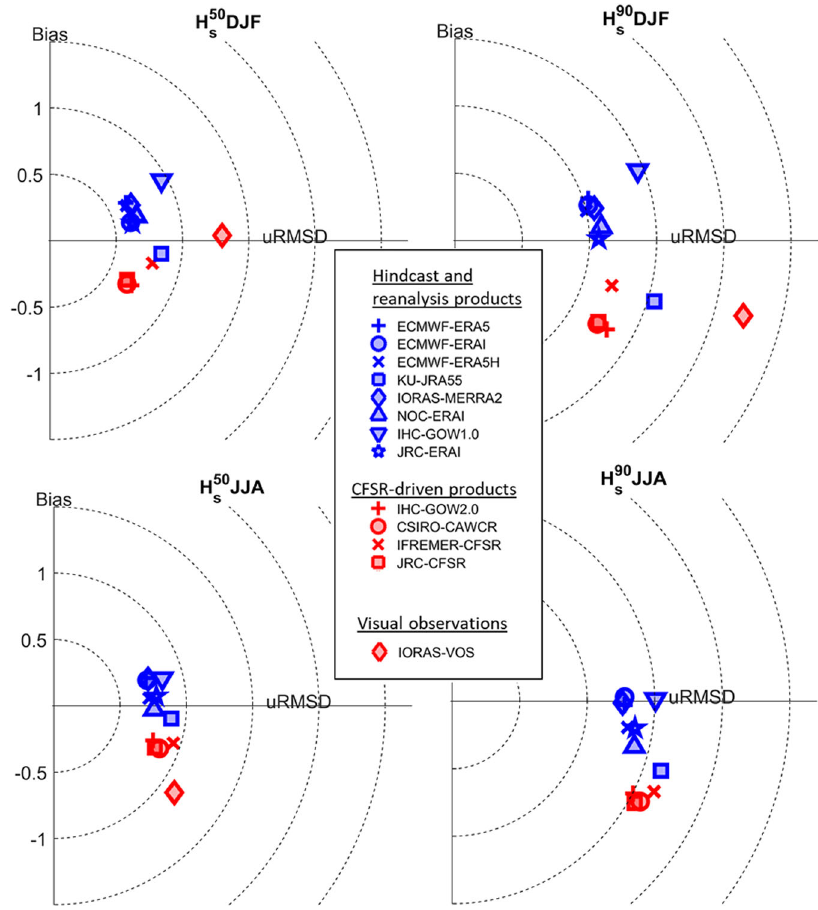
Fig. 8 Wave height trend skill statistics. Target diagrams summarizing skill statistics of 12 global wave model products and VOS compared to the reference IMOS (altimeter-derived) dataset. The horizontal axis shows the unbiased root-mean-square-error (urmse), and the vertical axis shows the bias (negative values indicate that hindcast/reanalysis/VOS products under-estimate compared to IMOS). The polar distance from the centre is the rmse. All units are cm per yr. Skill statistics are calculated over the time-period of the IMOS dataset, 1985 through 2014 (30